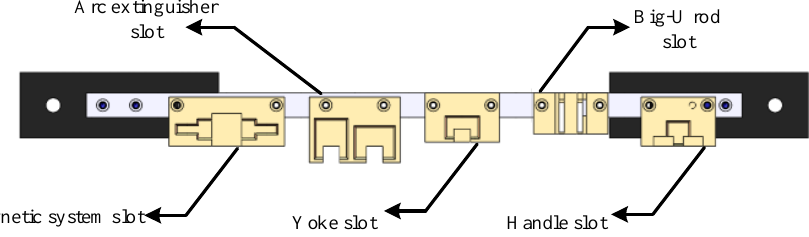
Figure 5. Auxiliary adjustment rack for the